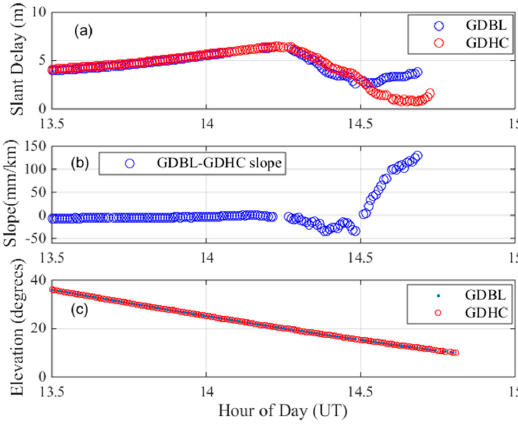
Figure 3. Maximum ionospheric gradient observed on 25 March 2017. ( a ) dual-frequency estimates of slant ionospheric delay; ( b ) ionospheric gradient; ( c ) elevation angles of PRN 30.